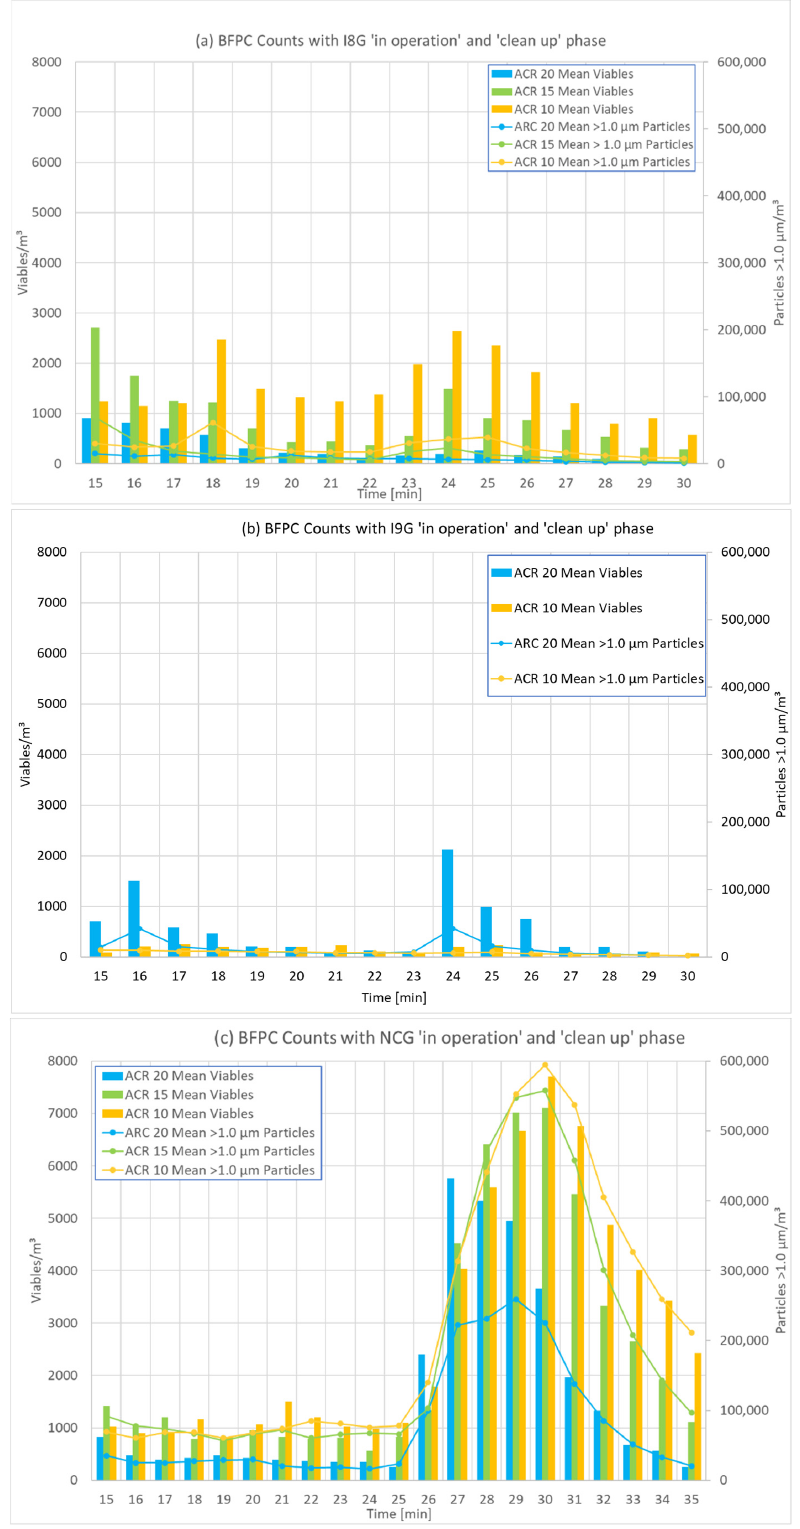
Figure 5. Particle and Viable/m 3 results at different ACRs: ( a ) with I8G/( b ) with I9G/5c with NCG (Please note the different scale on x -axes in Figure ( c ) to reflect the ‘spiking phase’).